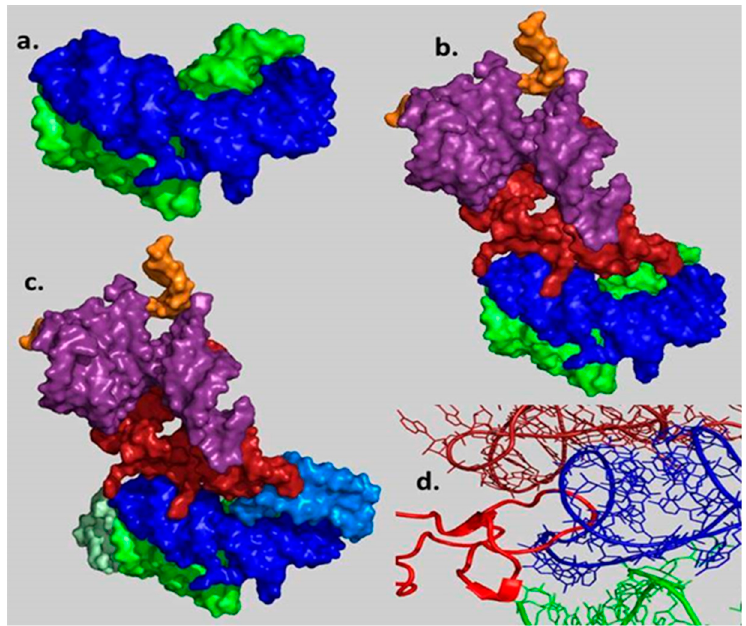
Figure 6. Evolution of the proto-ribosome ( a ) Stage 1: side view of the non-coding DPR pocket suggested to catalyze the peptide bond formation between random amino acids. ( b ) Stage 2: rear view (rotated by 90° around the vertical axis relative to Figure 5) of the initial coded proto-ribosome model capable of processively translating an RNA chain into a polypeptide. ( c ) Stage 3: the same view as in ( b ) after the addition of the A- and P-sites (in lighter hues) to the DPR, resulting in a higher connectivity with the bridging element. ( d ) Stage 4: protein incorporation. Interactions of the L2 loop (in red), suggested to be the first protein to join the coded proto-ribosome, with the A-, P-DPR and with the tail of the bridging element.